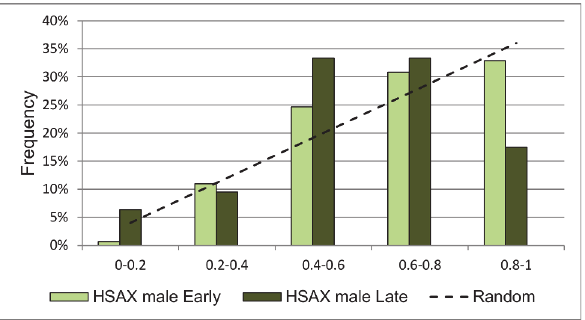
Fig 3. RDCs of HSAX in male cells at early and late passages. RDCs of HSAX in male cells change after prolonged cultivation (p = 0.03). Dashed line demonstrates random distribution for